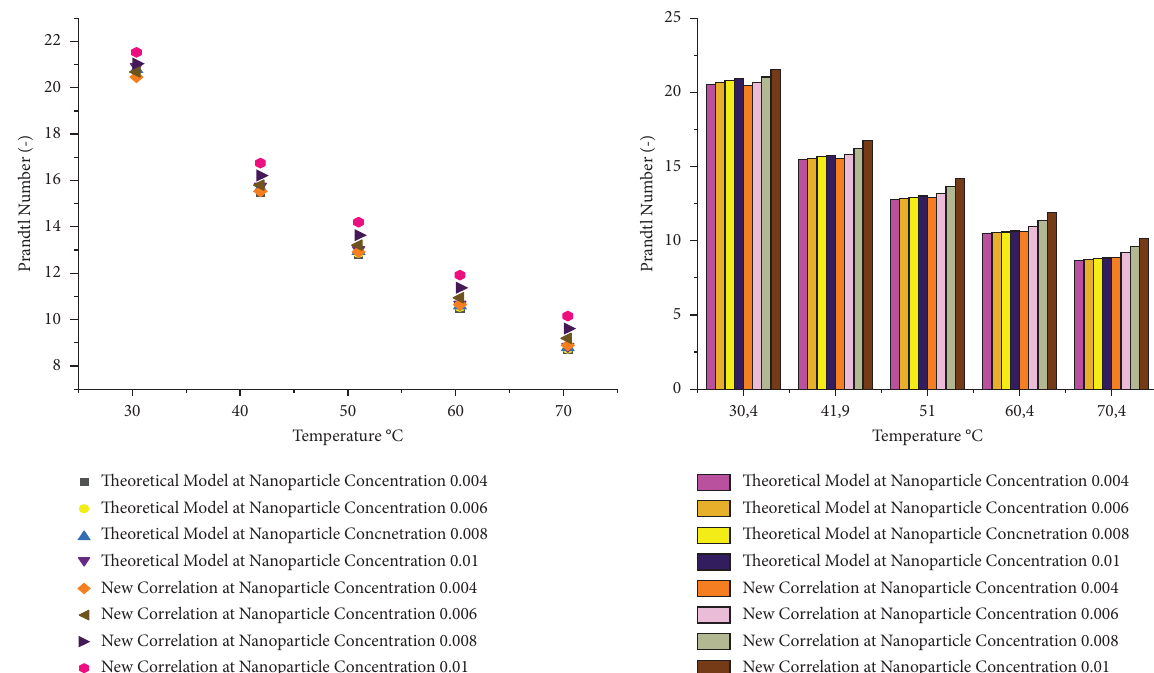
Figure 4: Comparison of titanium oxide-ethylene glycol (40%)/water (60%) nanofuid Prandtl number theoretical model and new